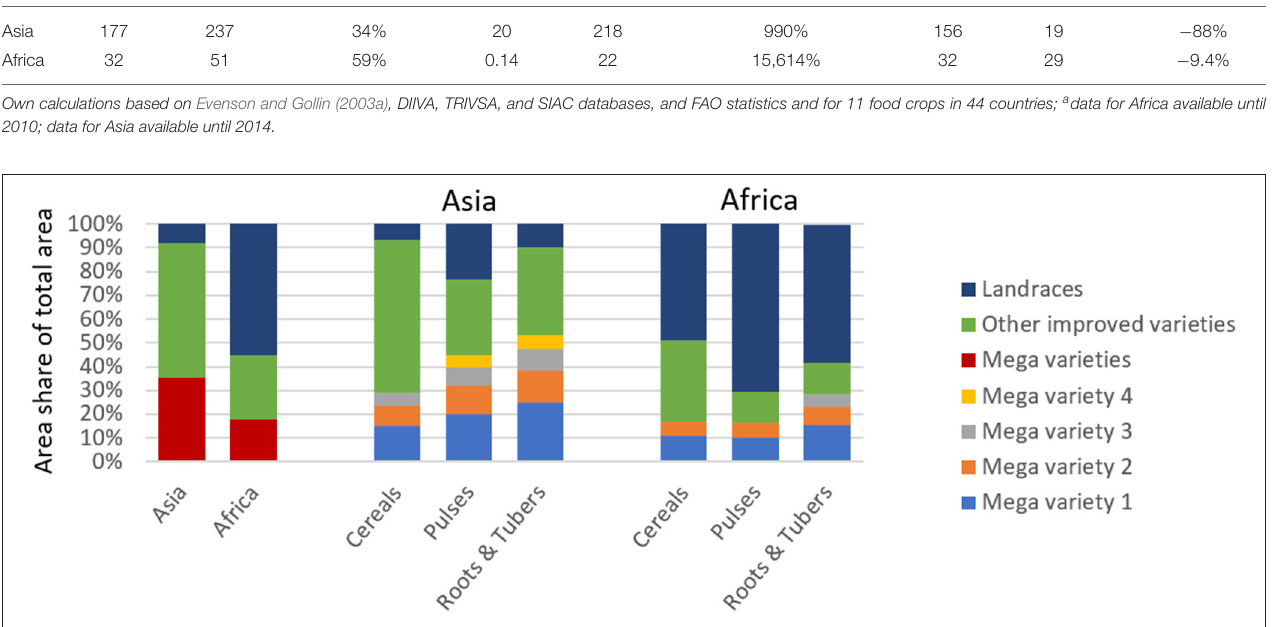
FIGURE 4 | Share of Mega and other Improved Varieties and Landraces of Total Agricultural Area in Asia and Africa. Comparison of mega varieties in terms of their relative share of total area by region and crop group. Variety is defined as mega if variety covers a minimum of 5% of total crop-specific area in a given country.